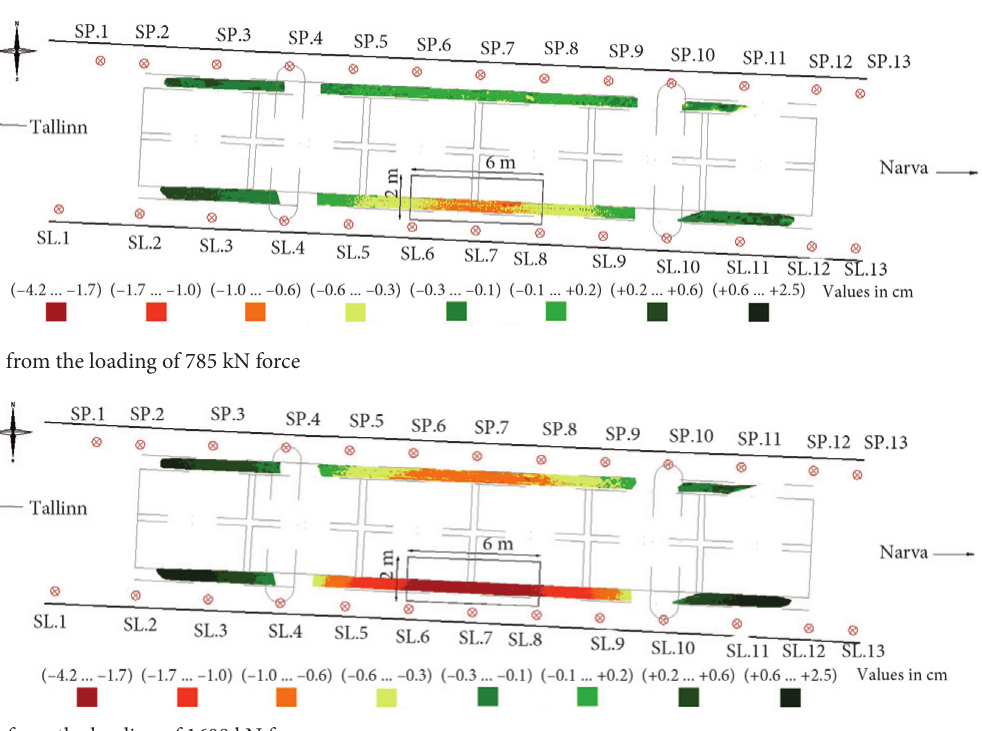
Fig. 8. Results from the loading of 1608 kN